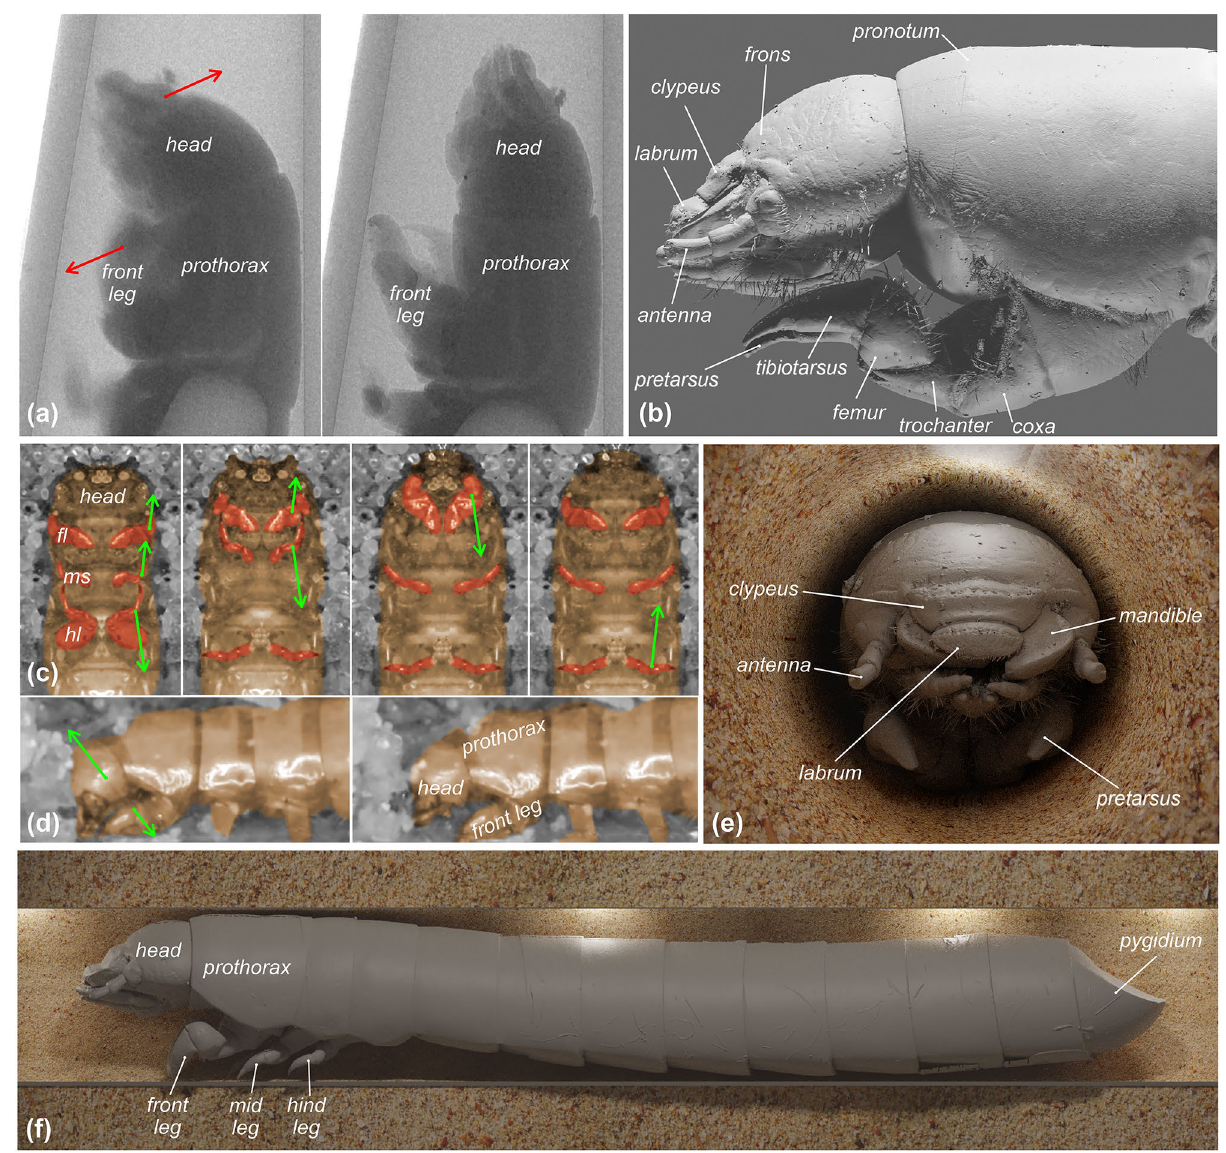
Figure 1. Burrowing dynamics and morphology of the sandworm beetle ( Gonopus tibialis ) larva. ( a ) Burrowing images obtained with microCT highlighting changes in head and front legs position. ( b ) Lateral view of larva imaging the relative position between head and front legs. ( c ) Ventral and ( d ) lateral burrowing images (fl— front legs, ml—middle legs, hl—hind legs). ( e ) frontal and ( f ) lateral microCT-based visualizations of digging larva. Arrows indicate the motion of particular